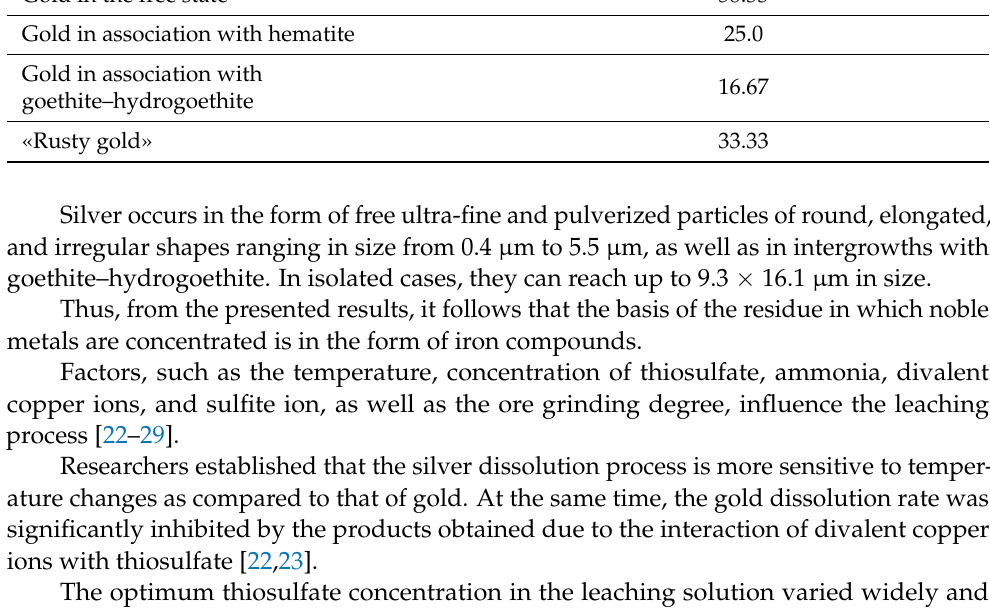
Table 4. Forms of gold in the remaining material. Forms of Gold % Gold in the free